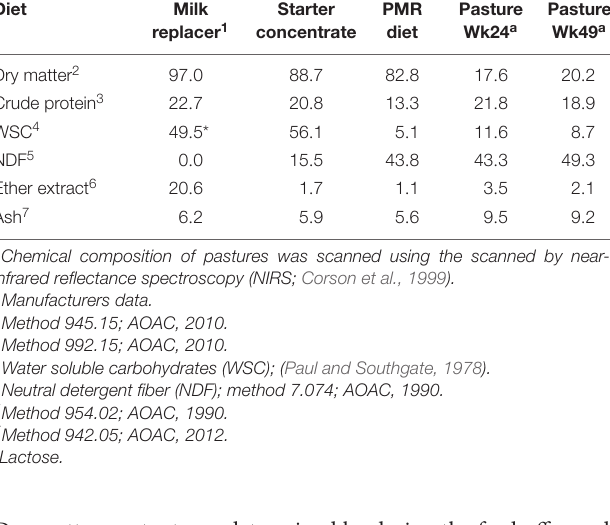
TABLE 2 | Chemical composition (g/kg) of the milk replacer, starter concentrate, partial mixed ration (PMR) diet and pastures.